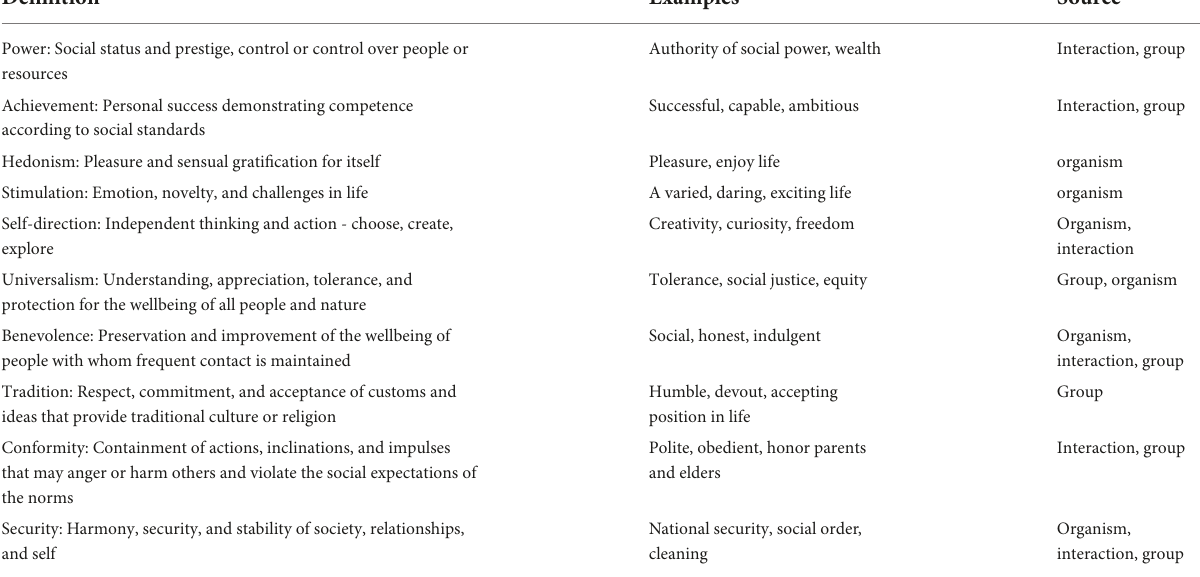
TABLE 1 Ten types of motivational